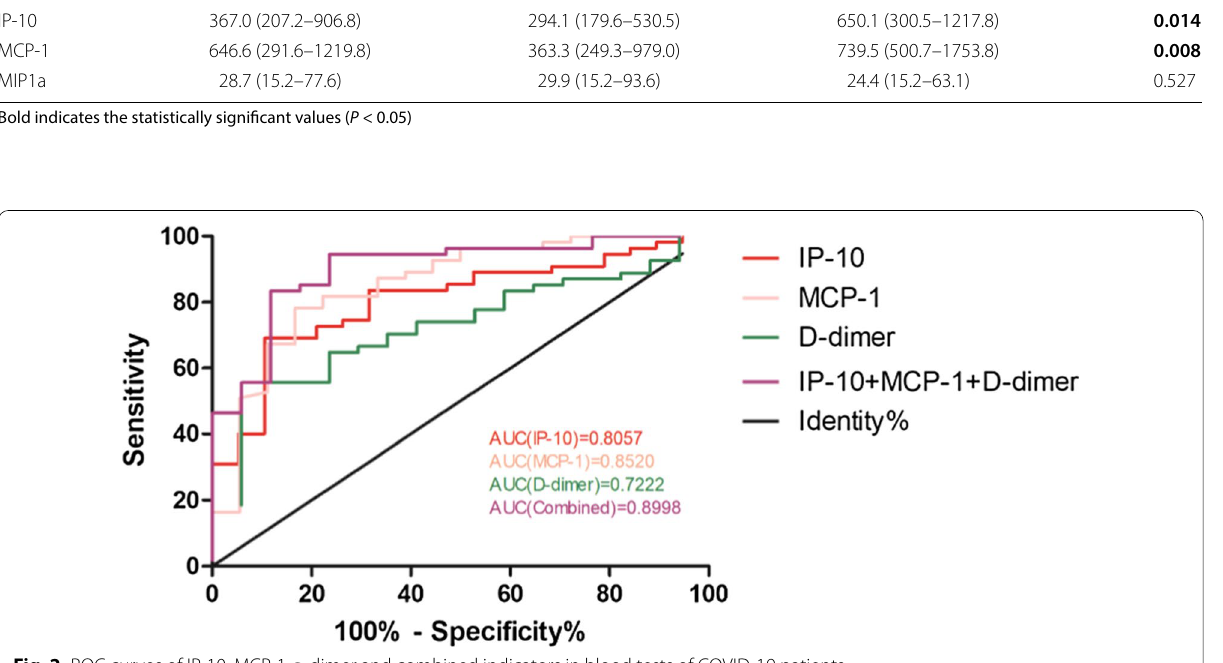
Fig. 2 ROC curves of IP-10, MCP-1, d -dimer and combined indicators in blood tests of COVID-19